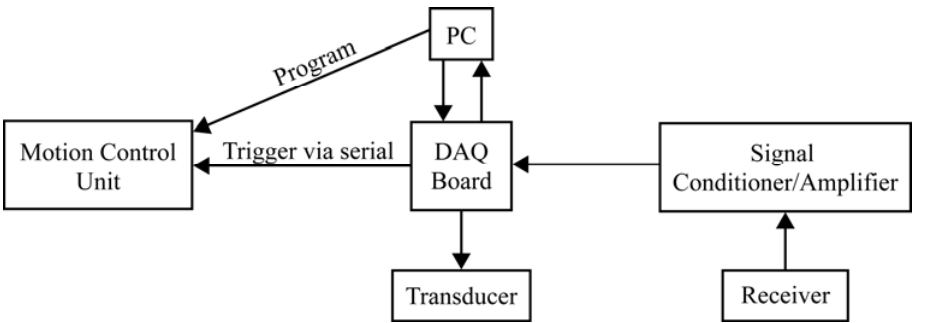
Figure 2. Functional diagram of the measurement and calibration